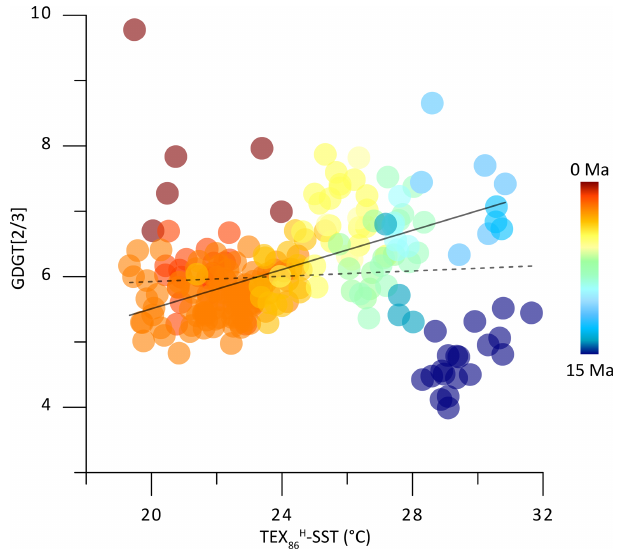
-SST and GDGT [ 2 / 3 ] . The oldest Figure 7. Cross-plot of TEX H 86 ( > 13 . 6Ma; dark blue) and youngest ( < 1 . 7Ma; dark red) samples largely stand out from the majority of the data. Linear regression lines determined from full dataset (stippled line) and samples dated between 13.6 and 1.7Ma (solid line; 88% samples, R 2 = 0 . 37, p < 0 .